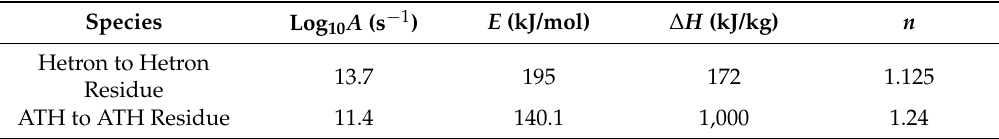
Table 4. Species decomposition properties.